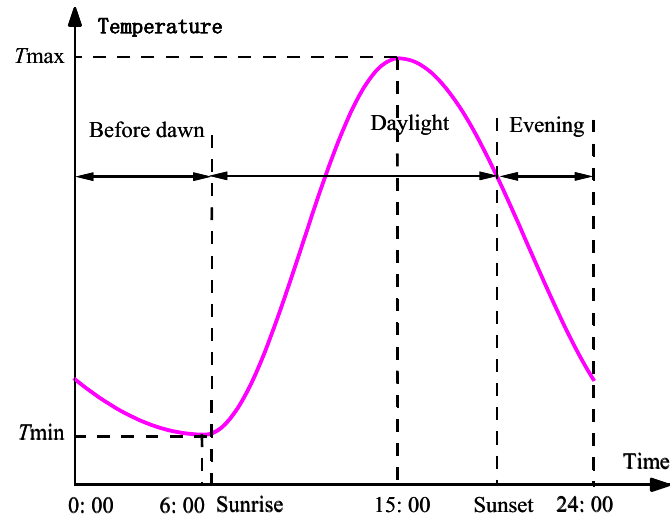
Figure 4. Daily temperature model.